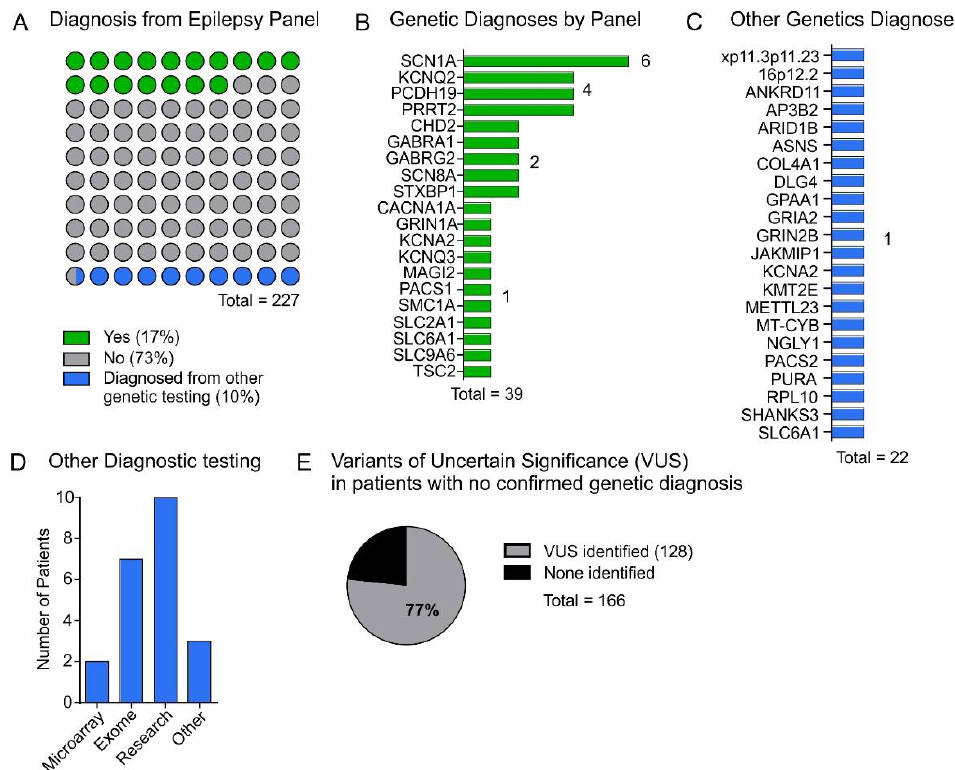
Figure 2. Panel testing results. ( A ) Dot plot representing overall epilepsy panel testing results ( n = 227). The panel test identified a genetic diagnosis “yes” in 17% of patients tested and 10% were diagnosed from other genetic testing carried out after the panel test. ( B ) Epilepsy-causing genetic mutations identified by panel testing. ( C ) List of genetic mutations identified by other genetic testing. ( D ) Other genetic tests that resulted in a diagnosis which explained the patient’s epilepsy phenotype. Research testing included research exomes and further targeted analysis, other testing including mitochondrial testing and other non-epilepsy panels ( E ) Of the 166 (73%) patients in our cohort without an identified genetic diagnosis 77% had variants of uncertain significance (VUS) identified.